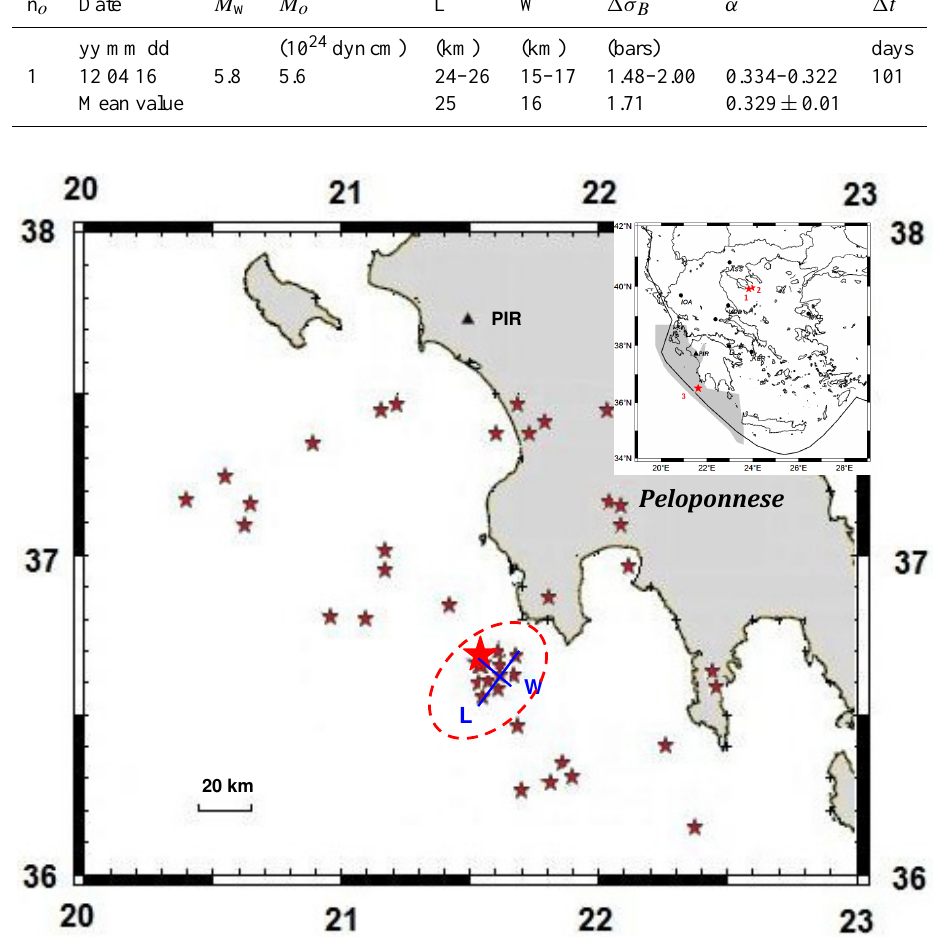
Fig. 1. Map of SW Greece, with all earthquakes (small red stars) with M L ≥ 2 . 3 reported by NOA from 16 April 2012 to 23 May 2012 in the area (36–38) ◦ N , (20–23) ◦ E. A big red star denotes the epicenter of the M w = 5 . 8 main shock on 16 April 2012, while a red dashed ellipse shows the location of the cluster of aftershocks. The cluster dimensions W and L are given in blue. A triangle depicts the location of the SES station PIR. The inset on the right top of the figure shows the selectivity map of PIR as shaded area, and the epicenters of the three earthquakes as red stars, numbered according to their order in the text. The M w = 5 . 8 earthquake is the number 3